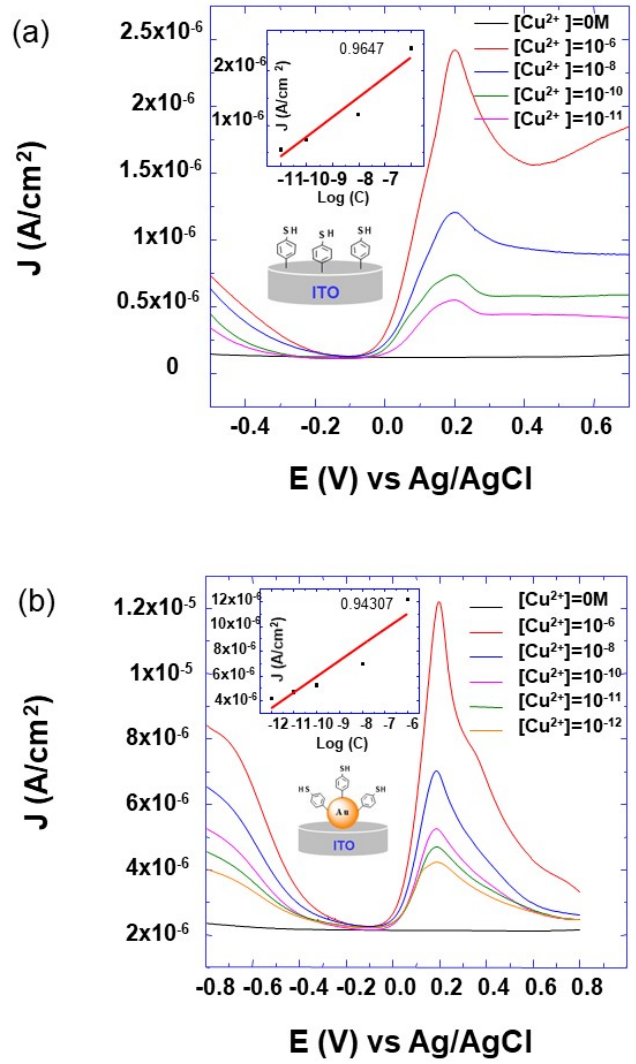
Figure 8. SWV voltammograms of modified ITO electrodes with different architectures of AuNPs and 4-thiolphenyl as indicated in the inserted sketch of ( a , b ), The measurements were recorded at a scan rate of 10 mV s − 1 , in aqueous solution of KNO 3 (10 − 1 M) free of Cu 2+ and after immersion in Cu 2+ solution of the indicated concentration.